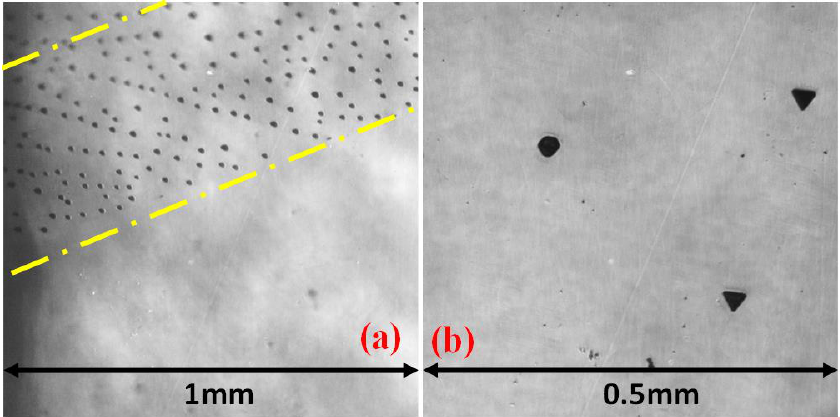
Figure 3. IR microscopy data for CRY-1 sample; ( a ) Te decoration on a dislocation side. ( b ) Large prismatic and triangular inclusions.